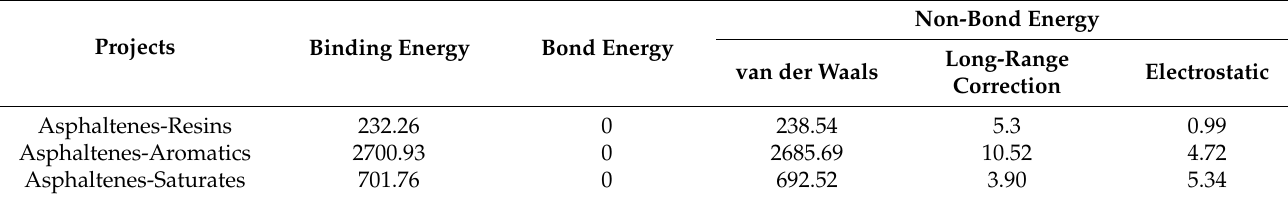
Table 3. Comparison of elemental content of asphalt samples and models.